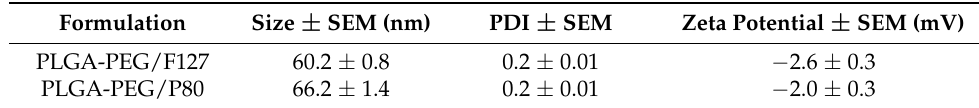
Table 1. Physicochemical properties of PLGA-PEG/F127 and PLGA-PEG/P80. All values are reported as mean ± standard error of the mean (SEM) (n = 3).